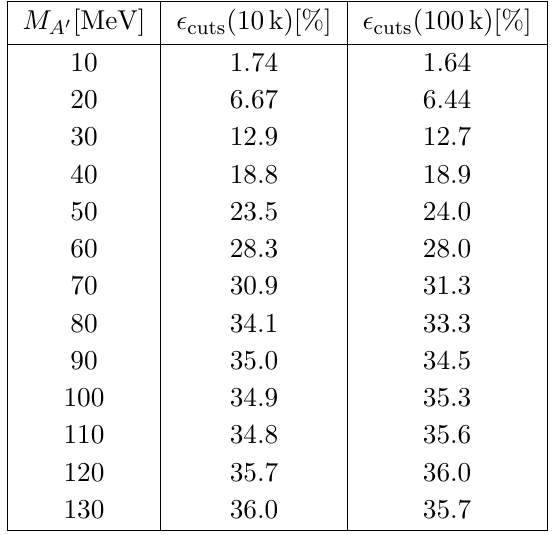
Table 4. Fraction of dark matter-electron scattering events (cid:15) cut passing the cuts on the recoil electrons as a function of the mass of the DP A 0 for the benchmark point reported in the listing in appendix D.3. We compare the results obtained by incresing the statistics on the requested interaction events from 10 k to 100